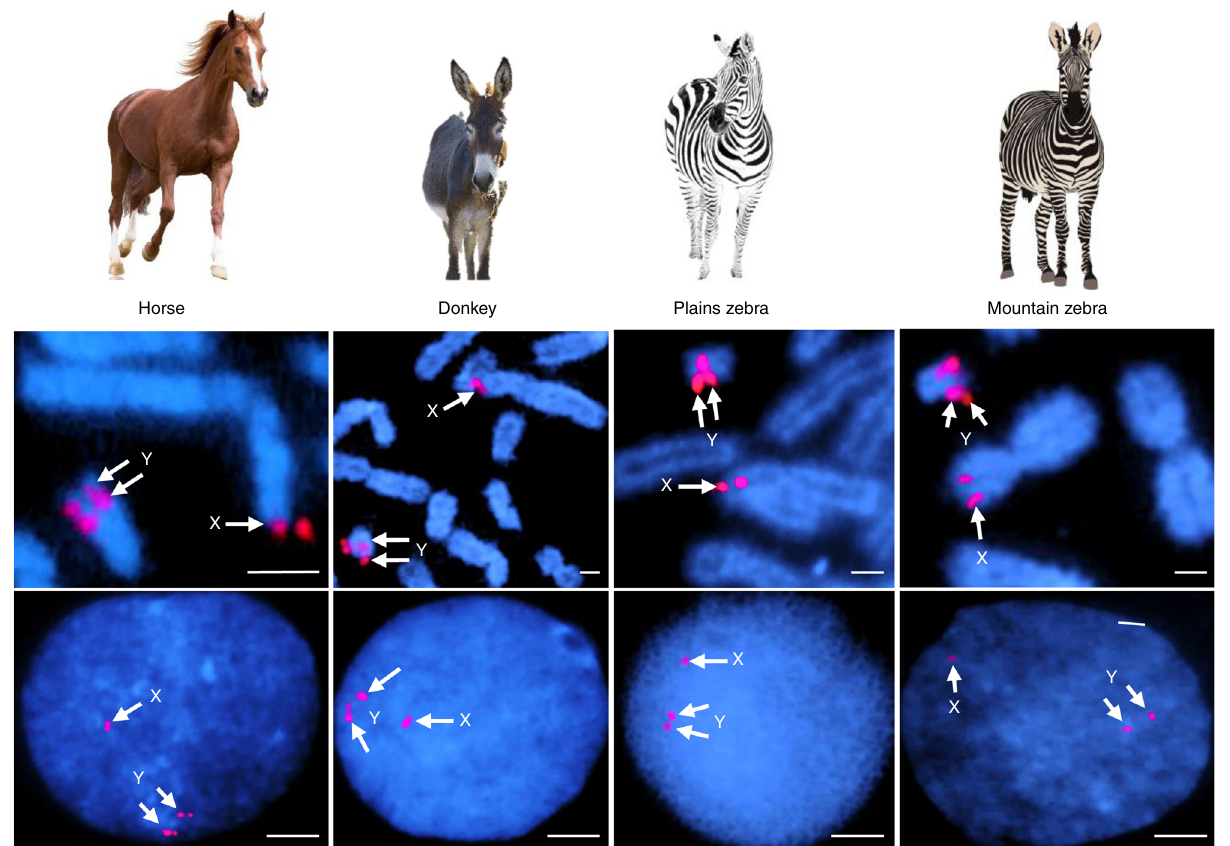
Fig. 2 PAR transposition to MSY in horses and other equids. FISH with BAC 100H13 (see Supplementary Fig. 1) in metaphase (upper row) and interphase (lower row) chromosomes showing that PAR transposition to MSY has occurred in horses, asses and zebras; arrows indicate 2 distinct hybridization signals in the Y (corresponding to Y-PAR and MSY transposed regions) and one in the X chromosome (corresponding to X-PAR). Scale bar 1 µ m. Equid images purchased from Bigstock (https://www.bigstockphoto.com/)